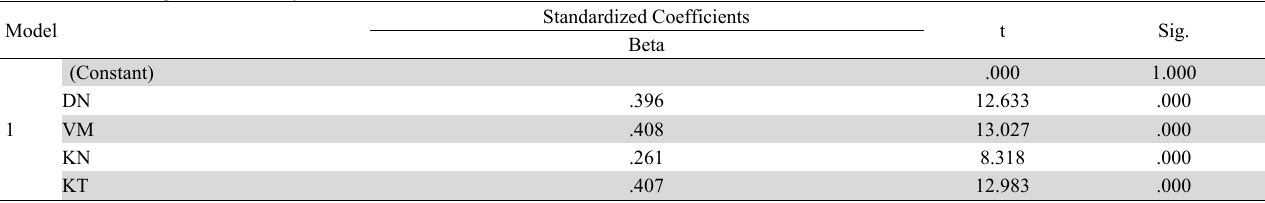
The results of regression